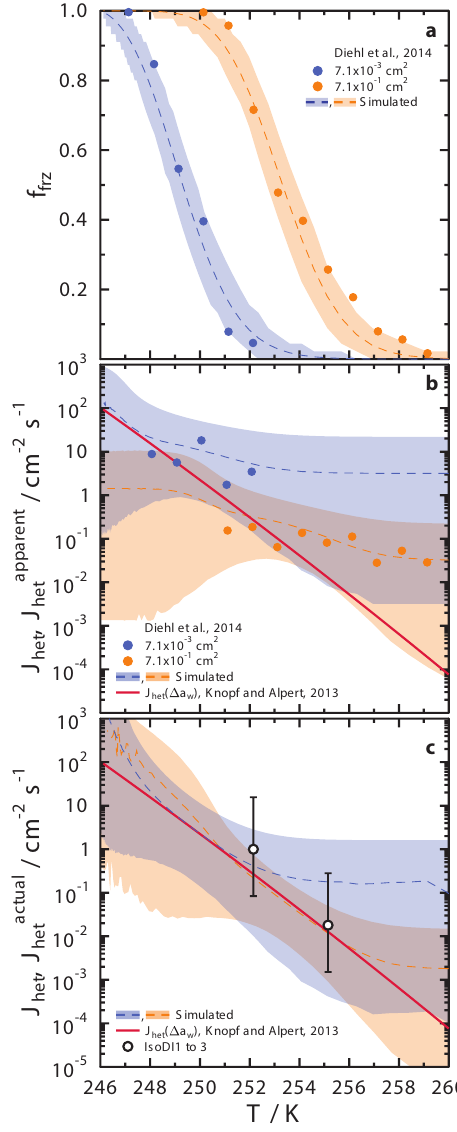
Figure 6. Frozen droplet fractions, f frz , and heterogeneous ice nu- cleation rate coefficients, J het , from immersion freezing model sim- ulations CrDI1 (orange) and CrDI2 (blue), and experimental data of illite acting as immersion INPs are shown (Diehl et al., 2014). Dashed lines and shadings in (a) are f frz and 5th and 95th per- centile bounds, respectively. J het as a function of temperature, T , are shown in (b) assuming uniform ice nucleating particle surface area (ISA) per droplet yielding J apparent and (c) accounting for het variable ISA yielding J actual . The dashed lines in (b) and (c) are het actual J apparent and J het , respectively. Shadings in (b) and (c) corre- het spond to upper and lower fiducial limits with x = 0 . 999 confidence. Experimentally derived f frz and J het are shown as circles in (a) and (b) , respectively (Diehl et al., 2014). The red line in (b) and (c) is calculated from Eq. (6) for illite (Knopf and Alpert, 2013). Parameter values for CrDI1 and CrDI2 are given in Table 2. Fit- ted J het values from model simulations IsoDI1 to IsoDI3 are shown in (c) and their corresponding error derived from Fig. 9 consider- ing N tot = 45, σ g = 3 . 2 and a temperature error, (cid:49)T = ± 0 . 7K